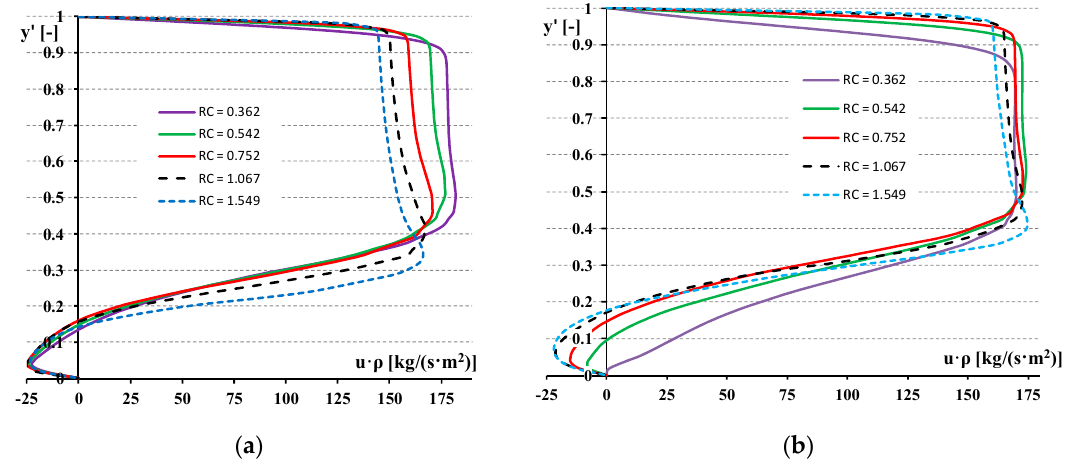
Figure 10. Distribution of the product of the velocity in the axial direction and the air density in the clearance for p 2 / p 01 = 0.9 in the section placed at (a) the half of the tooth thickness, plane A; ( b ) the outflow from the clearance, plane B.